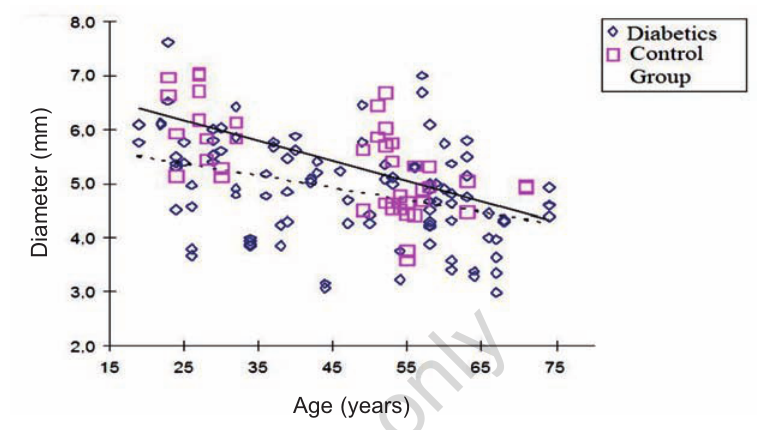
Figure 2. Pupil size as function of age in normal subjects and DM patients. Note the small- er size in DM patients in spite of large variance. Continuous line: linear fit to normal results; dashed line: linear fit to data of DM patients. The fraction of meiosis with the initial pupil diameter that was due to the age of the patient would be accounted for by the addition of 0.04 mm per year to the recorded initial pupil diameter. This reflects the average decrease of pupil diameter per year of life; so we used an age corrected initial pupil diameter (ACPD). It is important to note that because of the age factor leading to smaller pupils over 60 years of age the discrimination between diabetics and normal subjects by pupil size becomes less evident, but is still significant with p